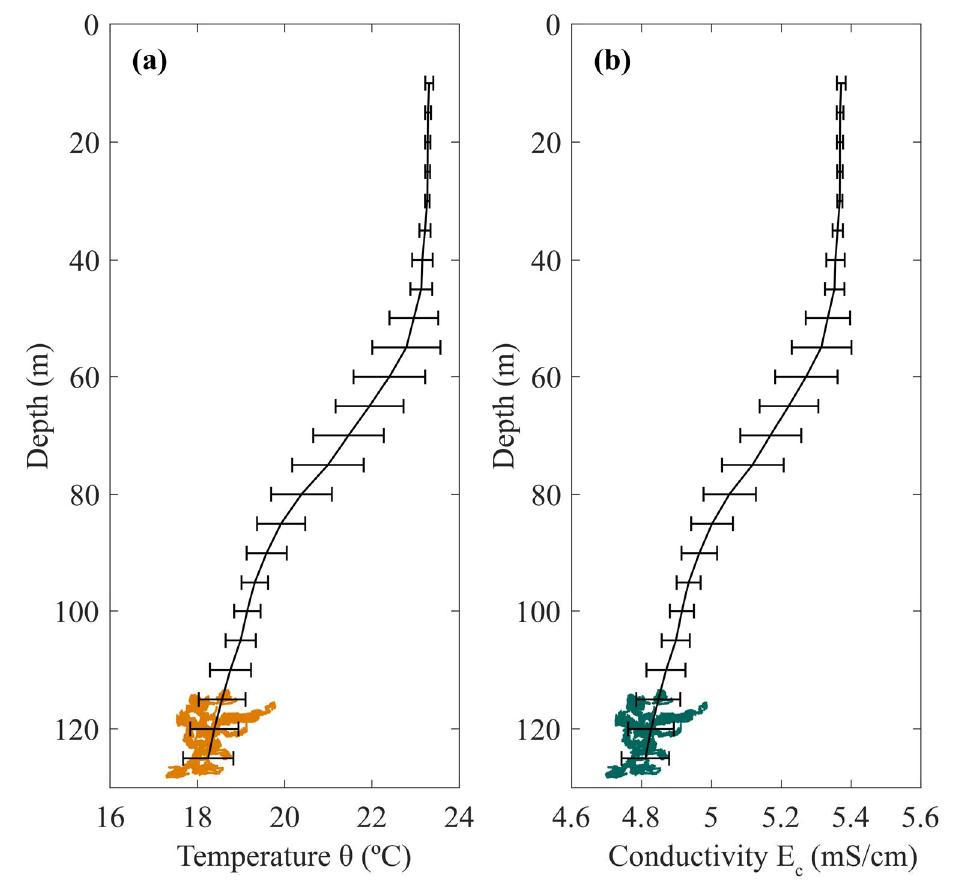
Figure 2. Mean vertical profile of ( a ) temperature, θ , and ( b ) conductivity, E c, with their standard deviation used as a reference from outlying stations not affected by the submarine volcano emissions. The time series fluctuations measured around and over the main crater, in orange for temperature and dark green for conductivity, are located close to 127 m depth.